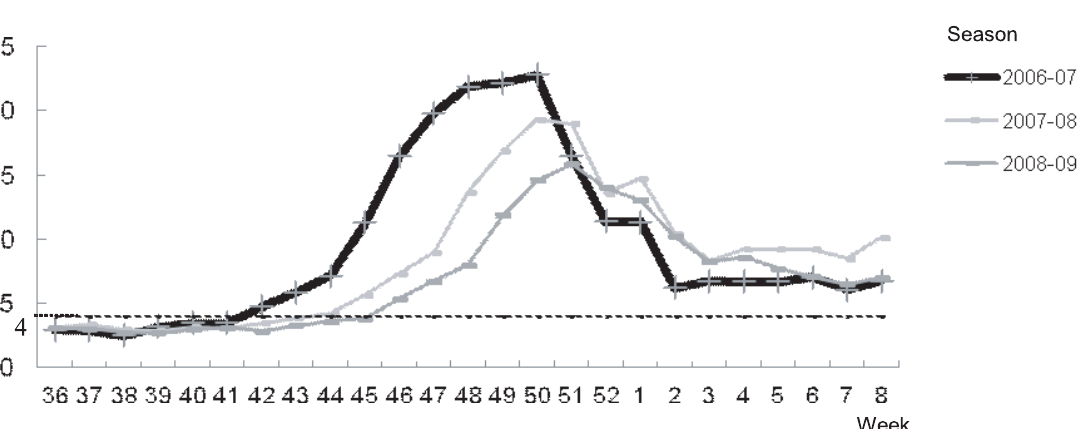
Figure 2. Nationwide weekly number of cases (per sentinel site) of norovirus gastroenteritis from 36th to 8th epidemiological week for the 2006–07 to 2008–09 seasons.